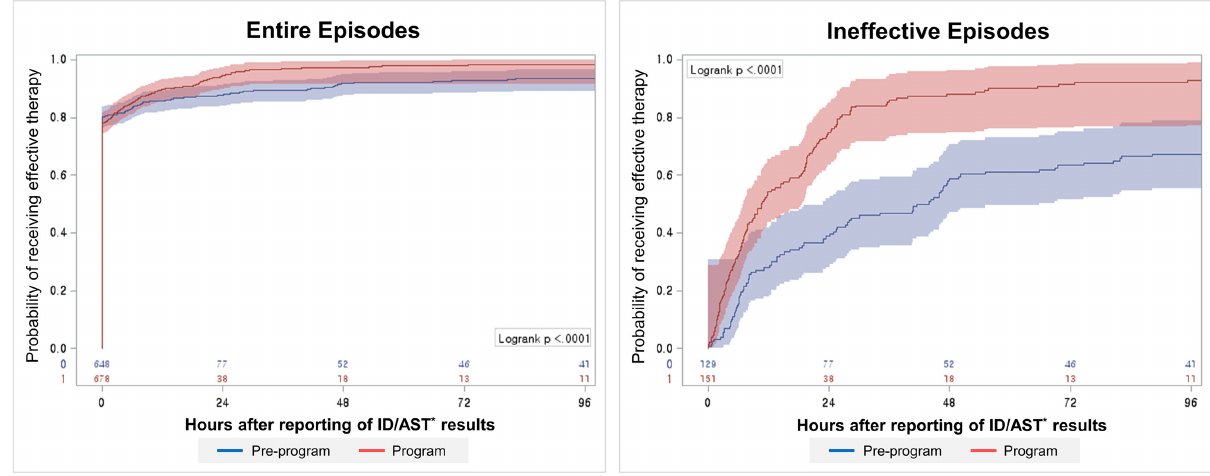
Fig 2. Kaplan-Meier curve of the time to effective therapy. * Identification and Antimicrobial susceptibility test.